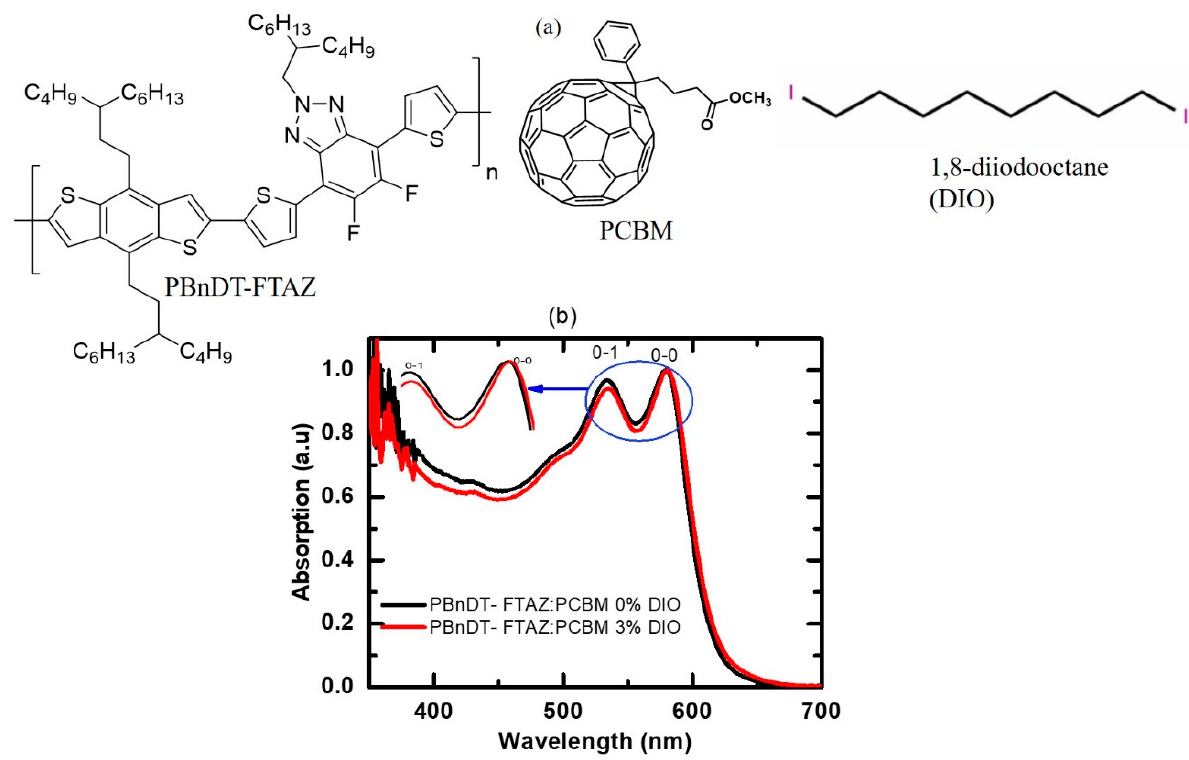
Figure 1. ( a ) Chemical structures of PBnDT-FTAZ, PCBM and DIO, and ( b ) absorption spectra of PBnDT-FTAZ:PCBM with and without DIO.